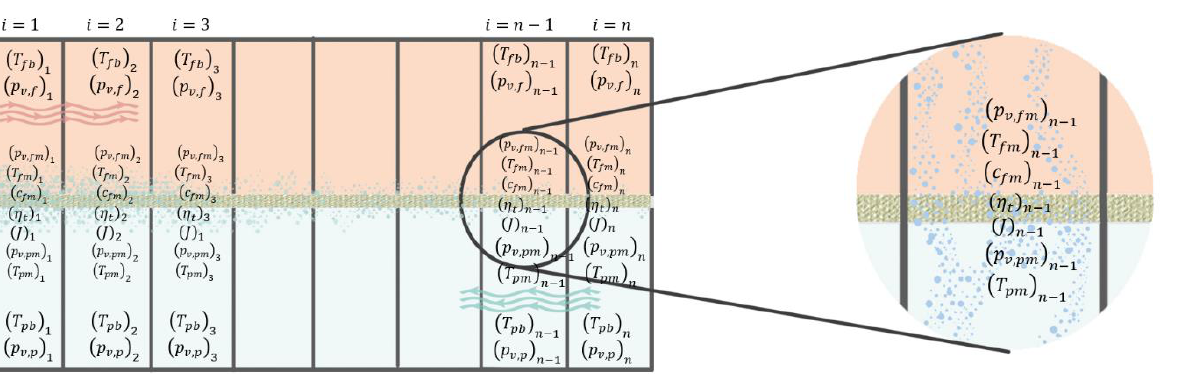
Figure 2. Elements used to study the downstream properties of a DCMD module. “T”, “c”, and “p v ’ represent the temperature, salt concentration, and water vapour pressure, respectively. Subscripts “f” and “p” refer to the feed and permeate sides, respectively, and ‘b’ and ‘m’ to bulk and membrane locations in the module. Membranes 2021 , 11 , x FOR PEER REVIEW